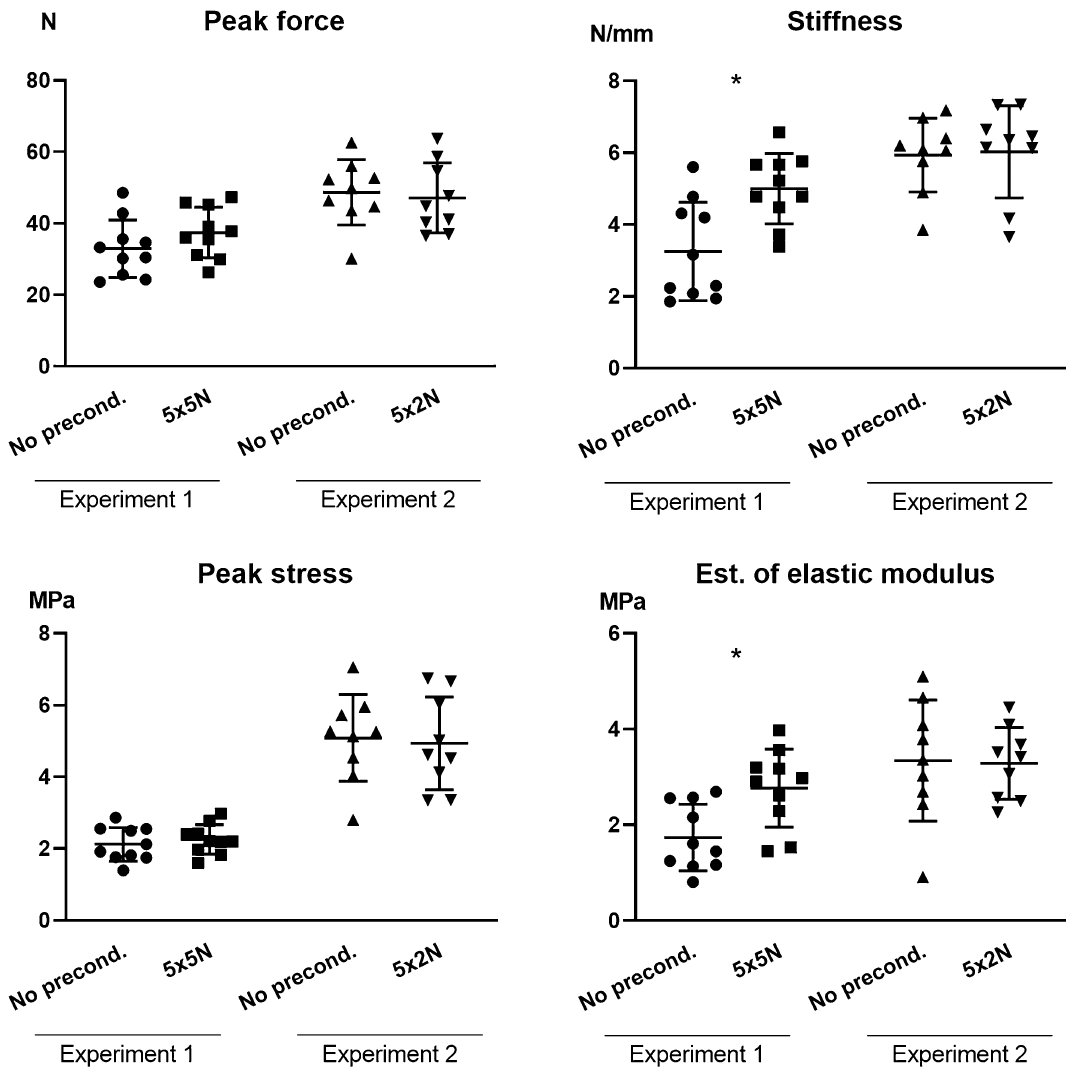
Figure 2. Mechanical results from samples with or without preconditioning. Preconditioning in experiment 1 was performed with 5 cycles up to 5 N (n = 10) and preconditioning in experiment 2 was performed with 5 cycles up to 2 N (n = 9). The preconditioned samples were compared to control samples without any preconditioning. N = Newton; x = cycles. The line represents the mean and the bars SD. Image created using GraphPad Prism software, version 8. https ://www.graph pad.com/scien tific -softw are/prism